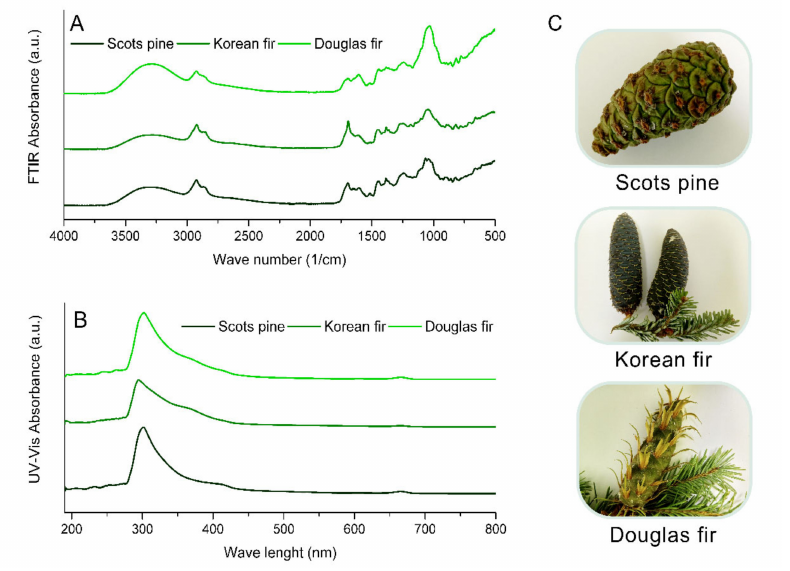
Figure 1. ( A ) FTIR and ( B ) UV–Vis spectra of Scots pine, Korean fir and Douglas fir cone extracts; ( C ) photographs of